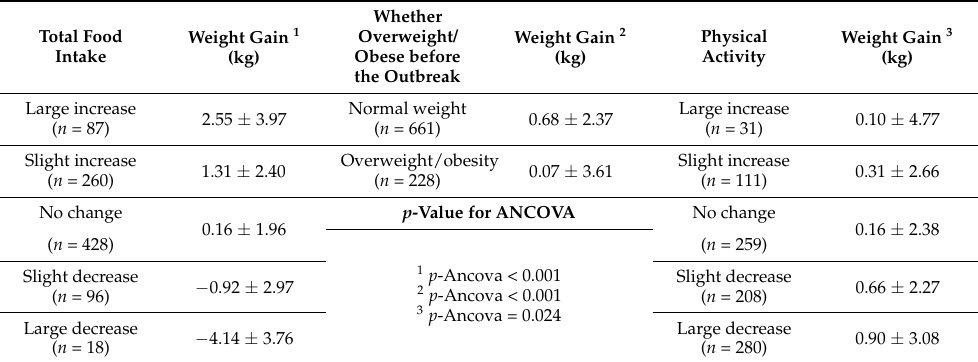
Table 5. Changes in total food intake and physical activity compared to before the outbreak, and pre-outbreak overweight/obesity effect on weight